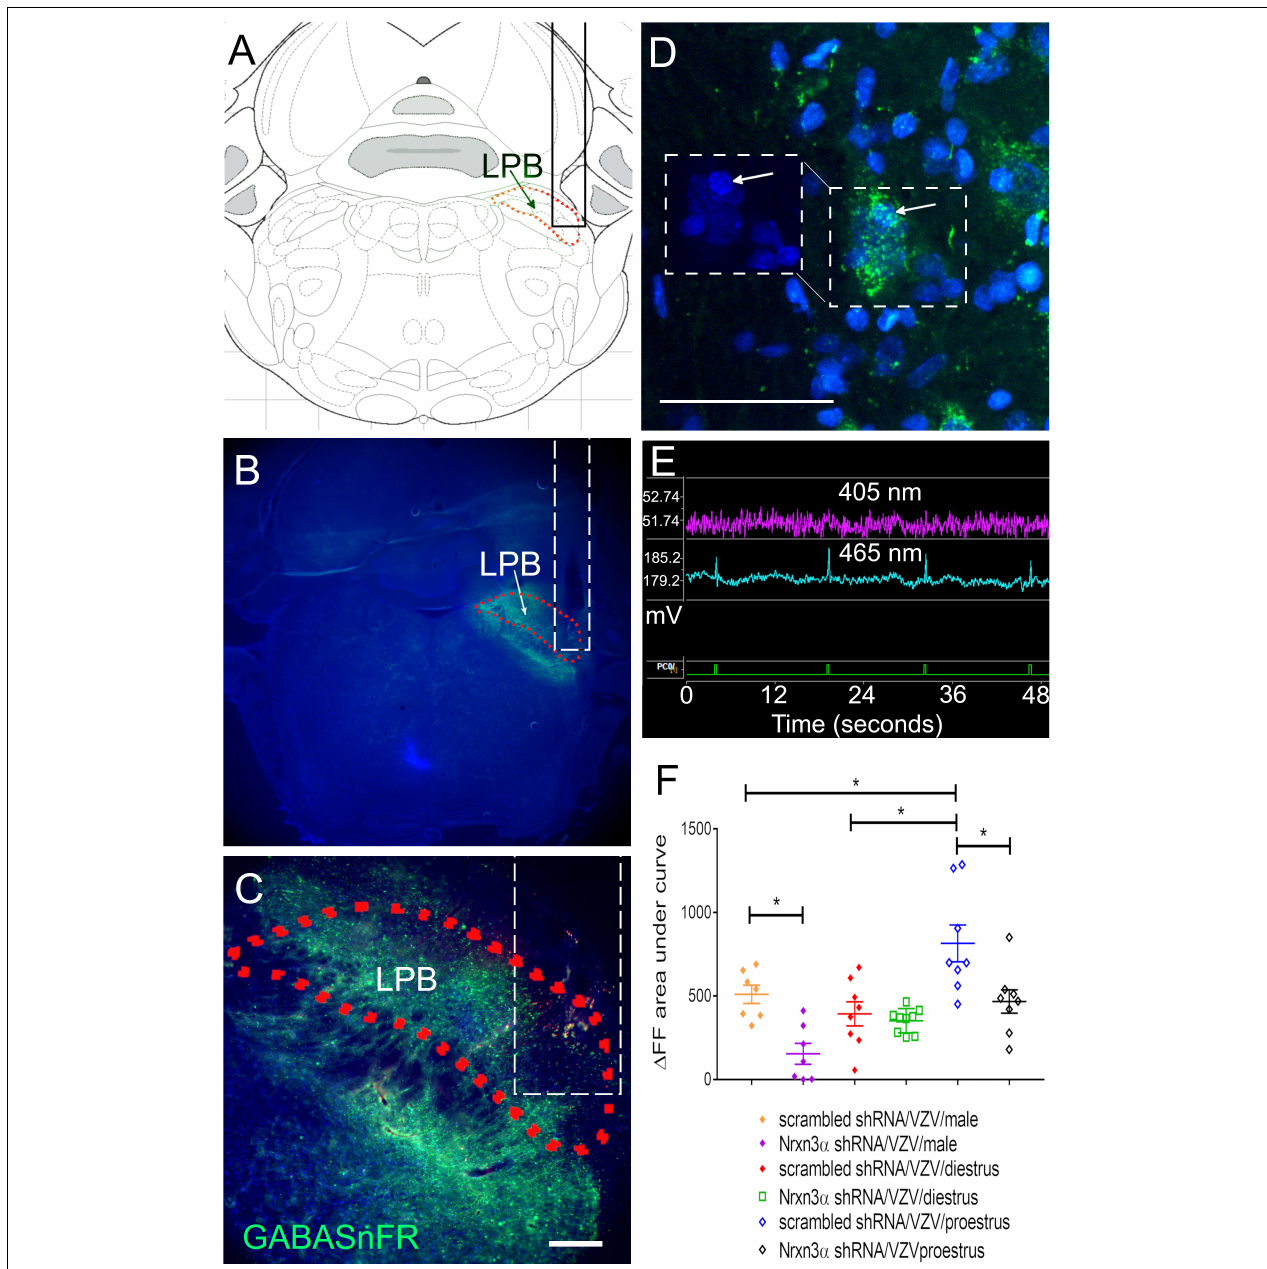
FIGURE 3 | Fluorescent image of lateral parabrachial from Long Evans rats after infusion of the parabrachial with an iGABASnFR construct. The central amygdala of male rats was bilaterally infused with lentivirus expressing either scrambled shRNA virus (control shRNA) or Nrxn3 α shRNA. The right lateral parabrachial (LPB) was infused with AAV1 containing an engineered GABA receptor (iGABASnFR). (A) Permanent optical fiber was implanted in the right lateral parabrachial after infusion of AAV. The outline of the optical fiber is shown as a solid black in (A) or dashed white line in (B,C) . Four weeks after brain infusion surgery the left vibrissae pad was injected with VZV and the animals sacrificed 2 weeks after injection for isolation of the brain. (A) Shows a brain atlas image corresponding to the section in (B) . (B) Is a low magnification image of the iGABASnFR fluorescent signal (green) is shown within the lateral parabrachial nucleus (outlined with a red dotted line) from a representative male rat. In (C) , the same parabrachial region is outlined by a red dotted line and is magnified. Bar = 200 µ m. In (D) , several magnified cells within the lateral parabrachial region stain for iGABASnFR (green). Boxed region on the right shows iGABASnFR (green) and boxed region on the left shows Hoechst 33342 nuclear stain (blue), arrow points to the same cell. Bar = 50 µ m. (E) Shows the isobesic 405 nm fluorescent signal (purple) measured in millivolts (y-axis, mV) over time (seconds, x-axis). The 405 nm fluorescent signal is related to motion artifacts. The electrical signal generated from the 465 nm fluorescent iGABASnFR signal (blue trace) results from excitation of iGABASnFR. Data was collected using the Tucker-Davis Instrument and Synapse software. The (cid:49) F/F was calculated using the 405 nm and 465 nm signals. The green trace at the bottom is when the button was pressed (PCO/is the button device connection slot into the instrument). A spike in the green trace indicates a button press. The animal was poked at the same time a button was pressed during behavioral testing. (F) Shows the (cid:49) F/F fluorescent signal for the engineered receptor resulting from binding GABA. Each point on the histogram represents an individual animal and the asterisk indicates p < 0.05.